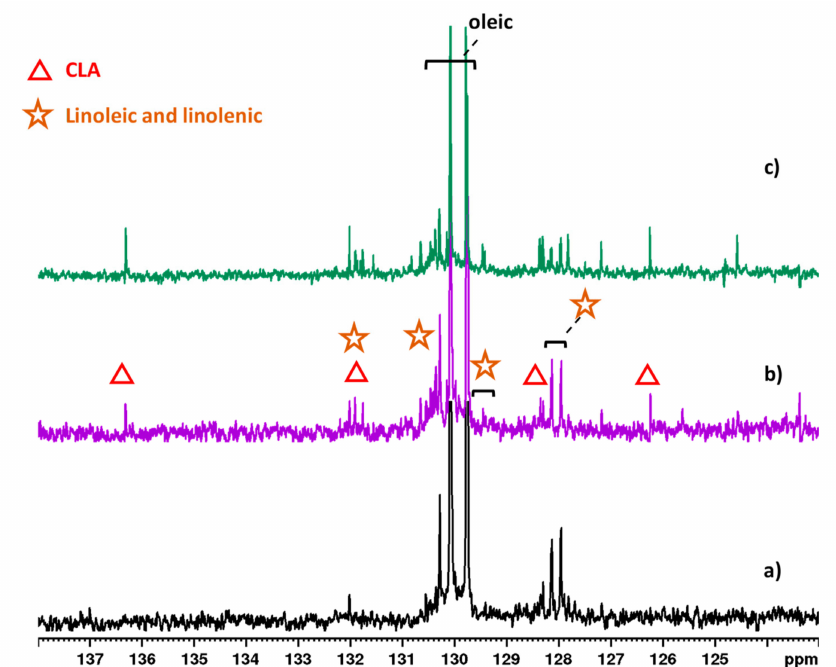
Figure 5. Olefinic region of 400 MHz 13 C NMR spectra of goat milk lipid fraction from ( a ) control, ( b ) hempseed, and ( c ) linseed diets in CDCl 3 at 298 K. Resonances highlighted with symbols refer to changes due to